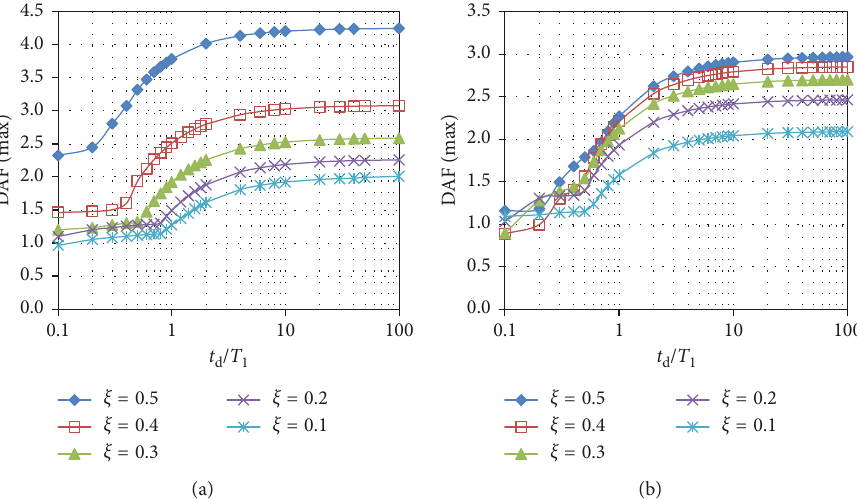
Figure 6: DAF (max) of shear force of bridge columns under impact load applied to different positions with right triangle shape. (a) F-F. (b)